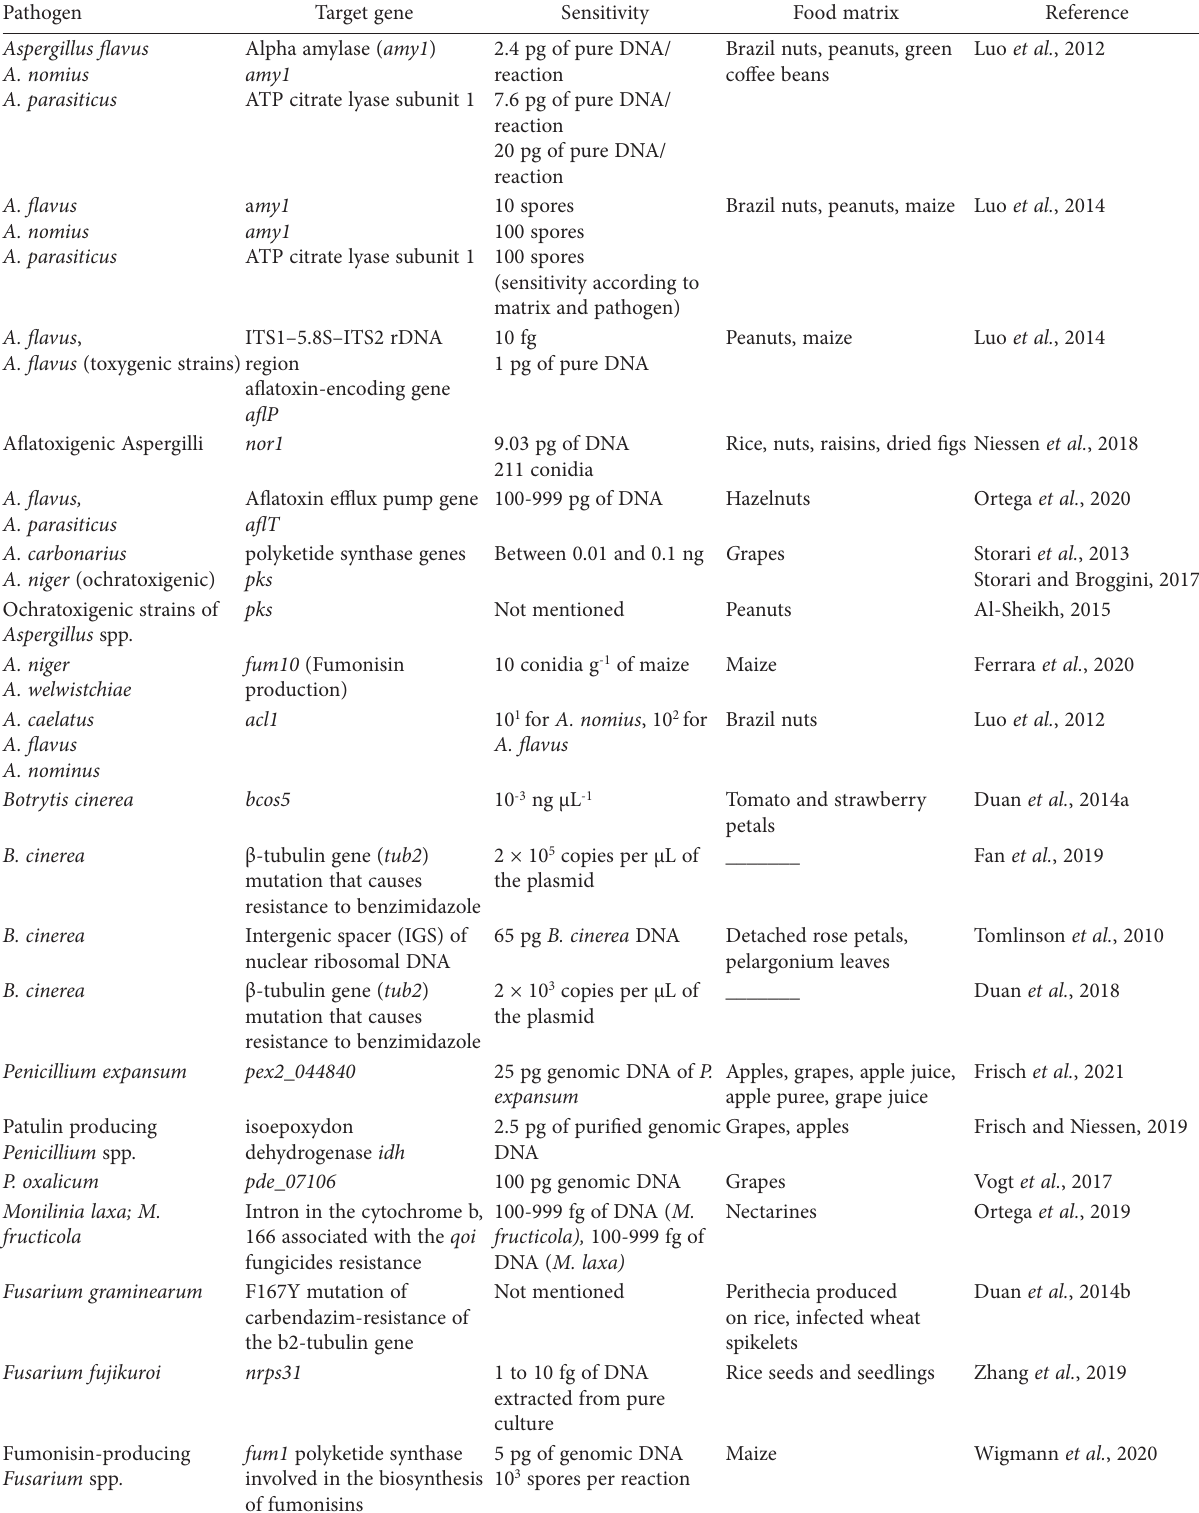
Table 2. LAMP assays developed for the detection of postharvest fungal pathogens.